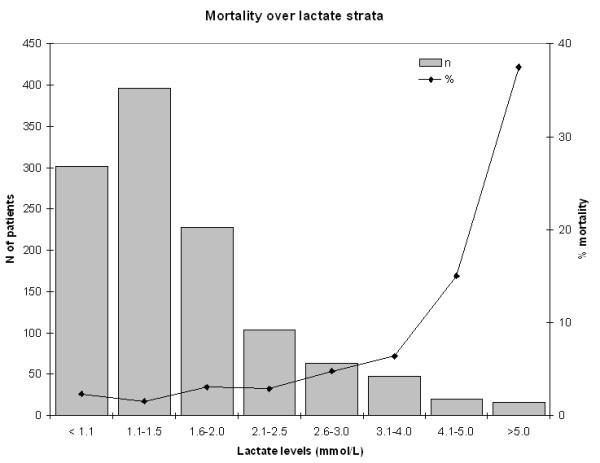
Distribution of 30-day mortality in relation to admission lactates.